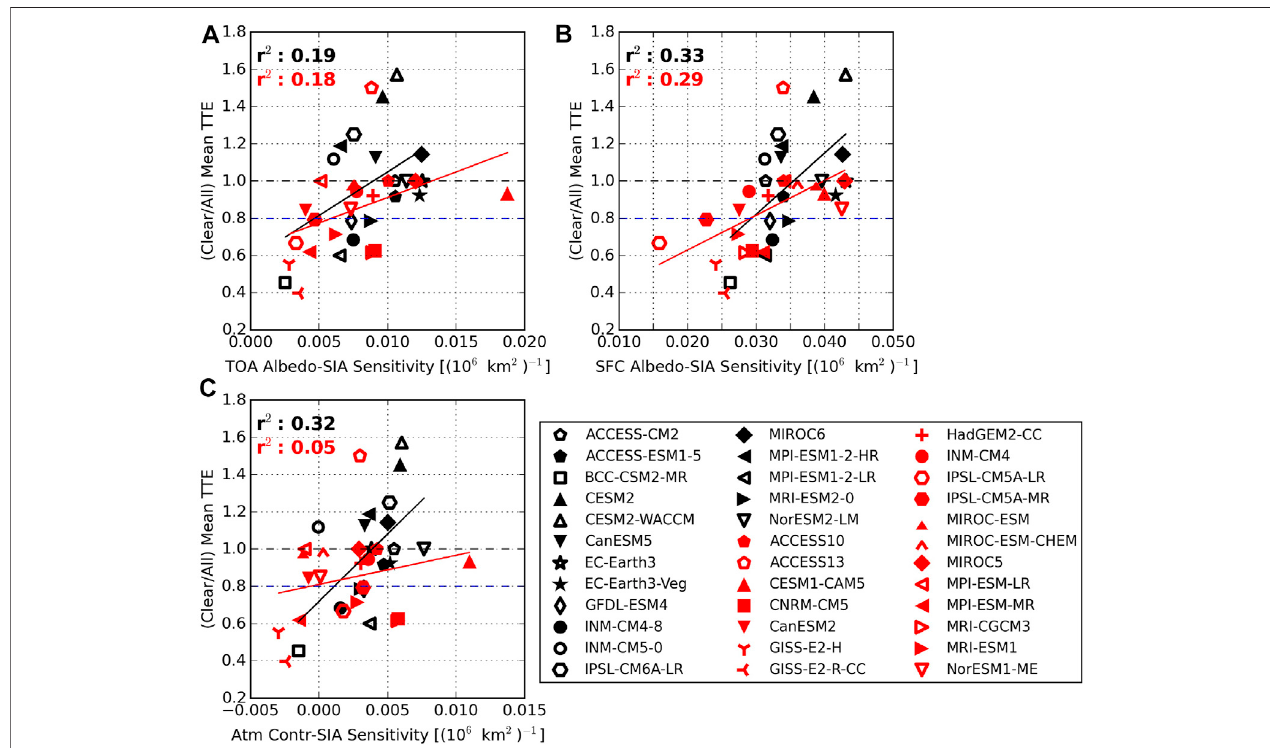
FIGURE 9 | Relationships between the ratio of all-sky to clear-sky SW acc TTE and the sensitivity of (A) TOA albedo, (B) surface albedo, and (C) the atmospheric contribution to September SIA. Results calculated from CMIP6 SSP585 are shown in black or while those from CMIP5 RCP8.5 are in red. Wherever possible, similar symbols have been adopted for models from the same center. TTE ratio from CERES (0.8) is shown as the blue dashed horizontal line for reference.